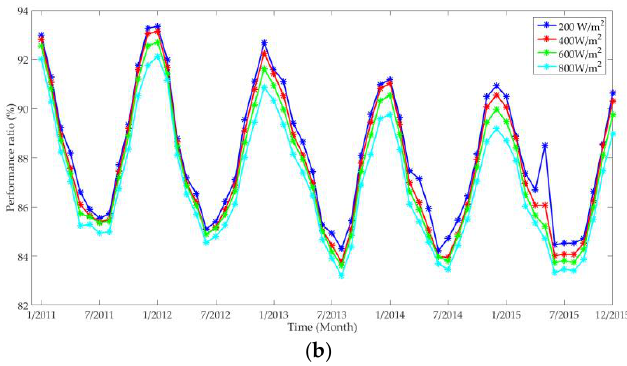
Figure 12. Monthly PR for various data filtering thresholds of POA irradiation: ( a ) UMG-Si PV; ( b ) mono-Si PV.